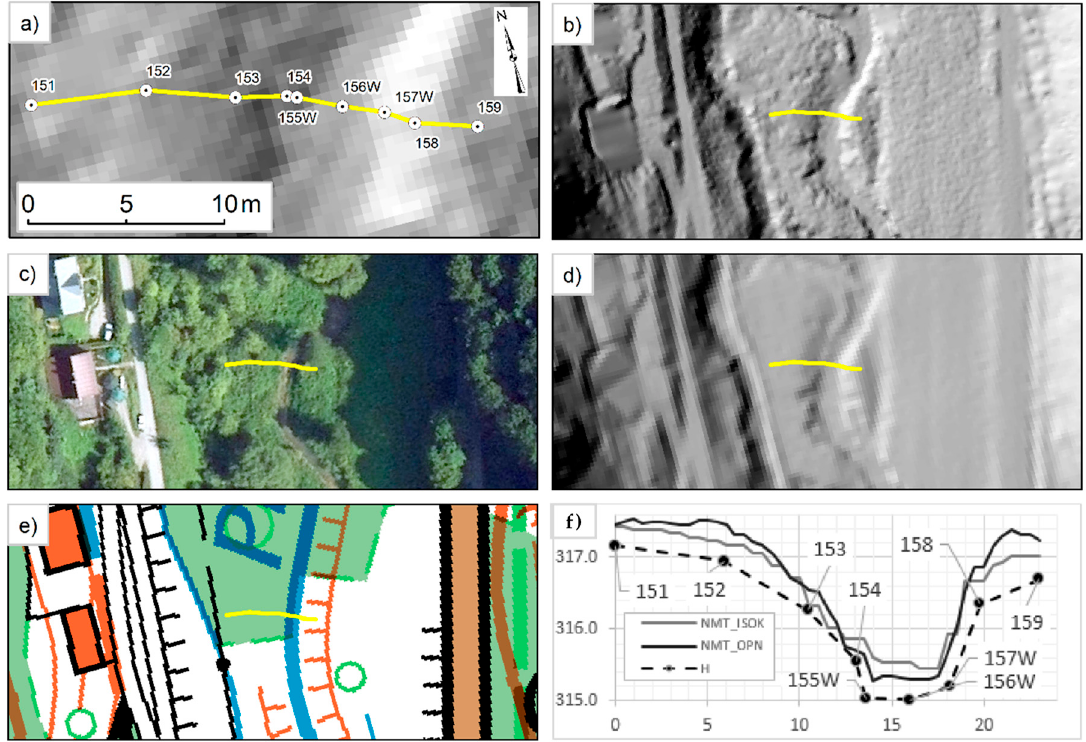
Figure 7. Cross-section profile No. 18. ( a , b ) on the hillshaded digital terrain model (DTM) ONP; ( c ) on the orthophotomap (2019); ( d ) on the hillshaded DTM ISOK; ( e ) on the topographic map 1:10k; ( f ) comparison of DTMs on the profile, W—surveyed points in water (a complete cross-section atlas is available in Supplementary